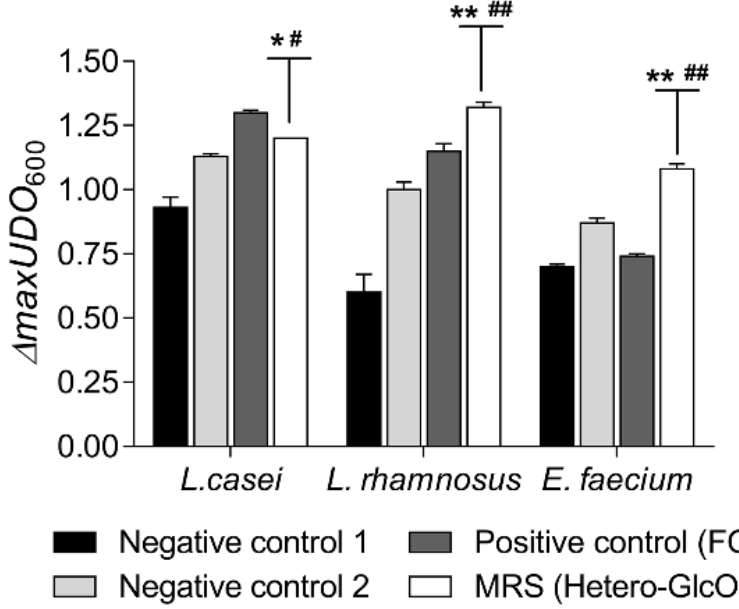
Figure 3. Maximal variation of turbidity ( ∆ max OD 600 ) of lactic acid bacteria cultures. Lactobacillus casei , Lactobacillus rhamnosus and Enterococcus faecium were inoculated for 24 h at 37 ◦ C in Man-Rogosa- Sharpe (MRS) medium with: no carbon source (black bars), glucose, fructose and sucrose (grey bars), the commercial FOS mixture (dark grey bars) and the mixture of hetero-GlcOS (white bars). Error bars represent the standard deviations from three independent analysis. Differences ( p < 0.05, p < 0.01) with the negative and positive controls are indicated with (*) and (#), (**) and (##), respectively.